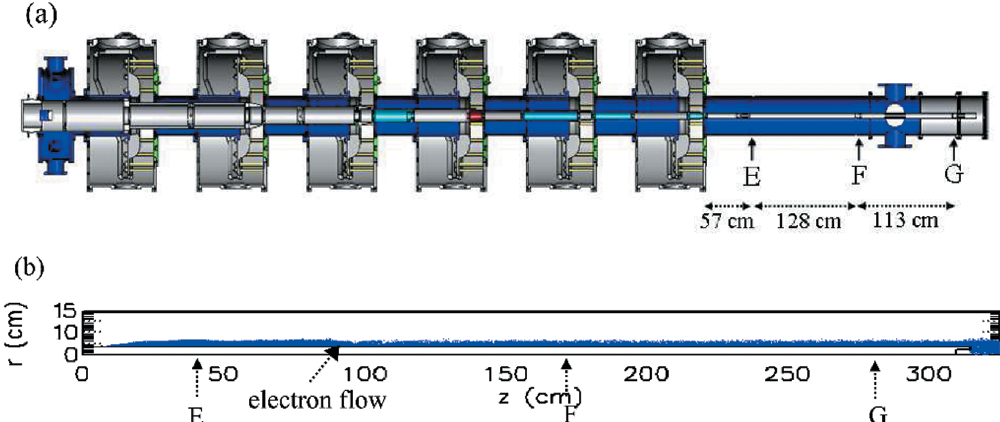
FIG. 1. (Color) (a) Cross section of the RITS-6 induction cell cavities and MITL. (b) Cross sectional view (cid:2) r; z (cid:3) of simulation geometry which begins near the sixth induction cell. The forward-going voltage wave is injected at z (cid:4) 0 . The particle plot in (b) illustrates the simulated electron flow at 60 ns into the pulse for a 73 - (cid:1) load. Diagnostic locations E, F, and G are marked by